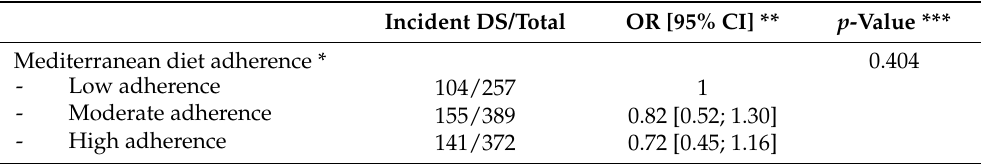
Table 3. Association between Mediterranean diet adherence and the risk of depressive symptomatol- ogy (i.e., CES-D score ≥ 16 and/or antidepressant treatment) ( N = 1018). Incident